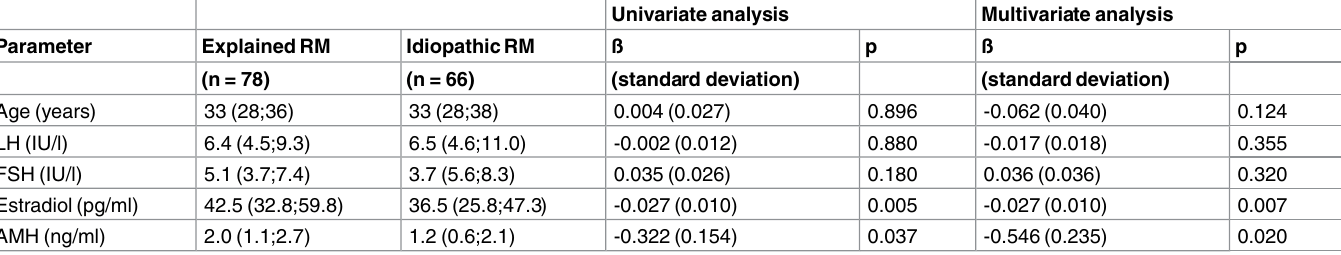
Table 2. Uni- and multivariatebinarylogisticregression modelsfor the predictionof idiopathicrecurrentmiscarriage.